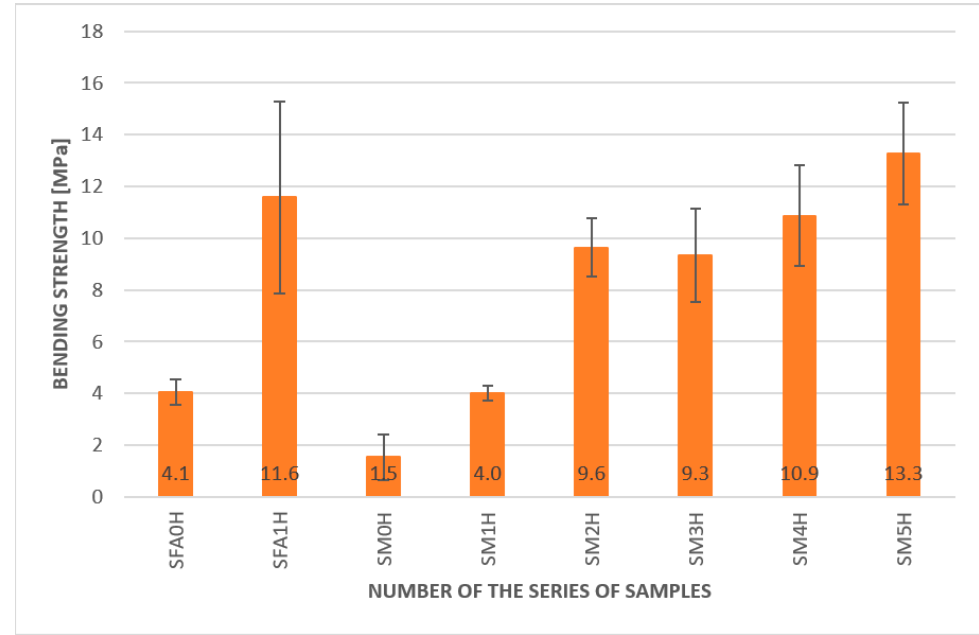
Figure 8. Results of the bending strength test for geopolymer composites at elevated temperature.